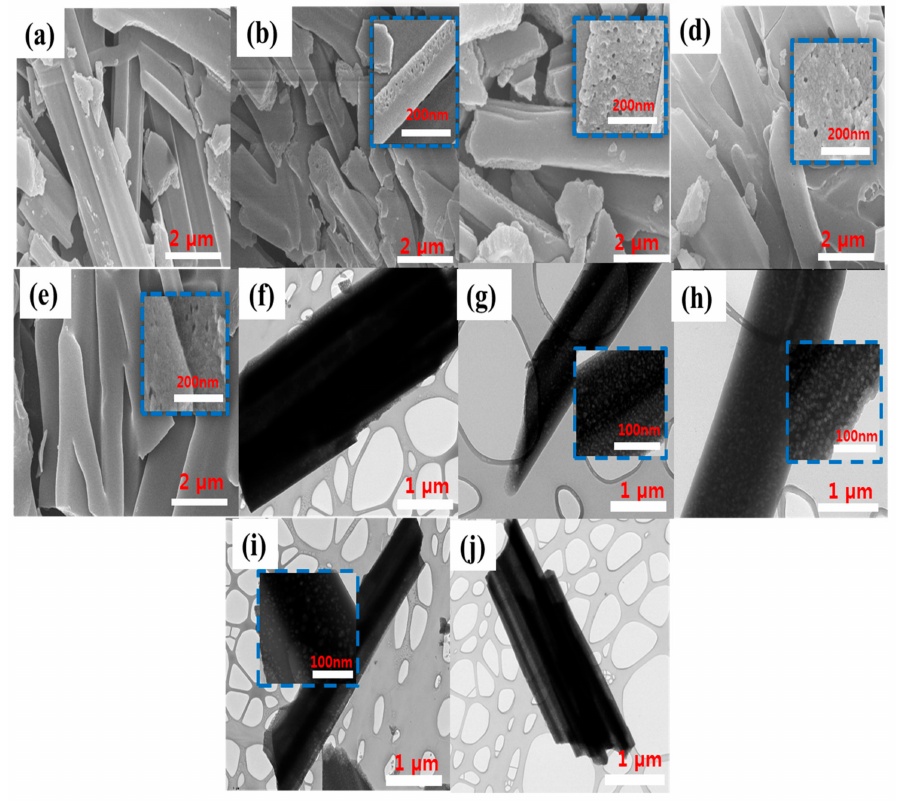
Figure 2. HR-SEM micrographs of samples ( a ) CBNW, ( b ) P123-CBNW0.5, ( c ) P123-CBNW1, ( d )P123-CBNW2, and( e )P123-CBNW3. TEMimagesof( f )CBNW,( g )P123-CBNW0.5, ( h )P123-CBNW1, ( i ) P123-CBNW2, and ( j ) P123-CBNW3. Insets show the high resolution photographs of the adsorbent